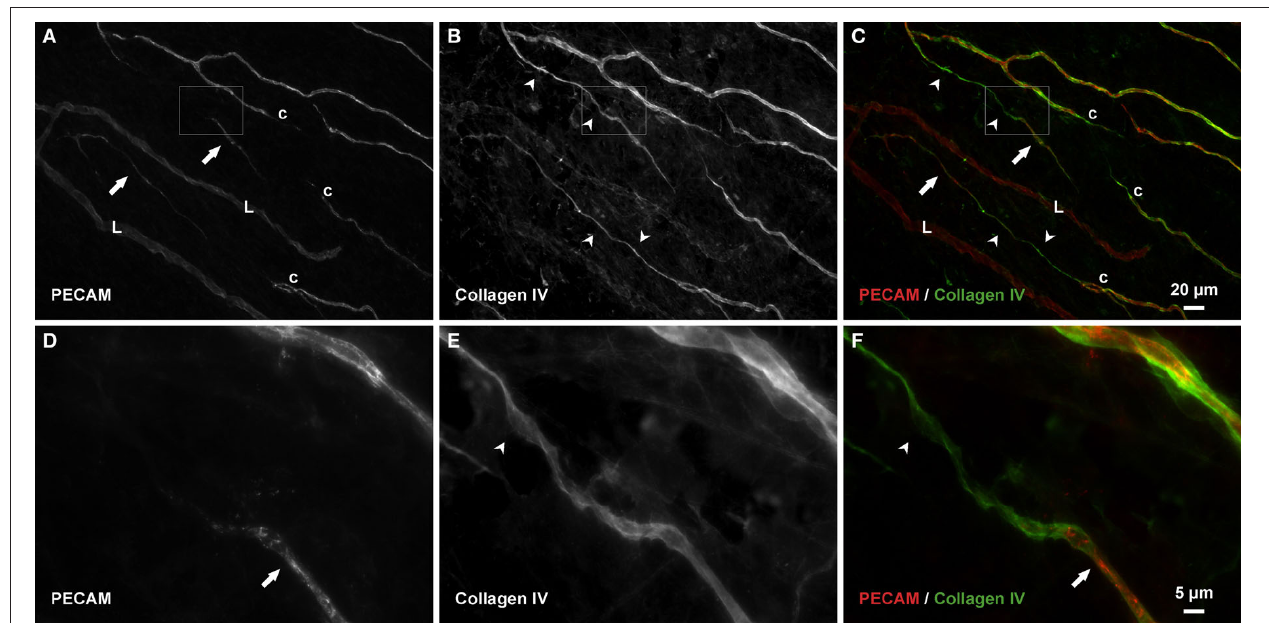
FIGURE 6 | Collagen IV tracks connect vascular islands to nearby networks and other vascular islands. (A–C) An example of PECAM-positive endothelial cells along vascular islands (arrows) with positive collagen IV connections to nearby networks (arrowheads).